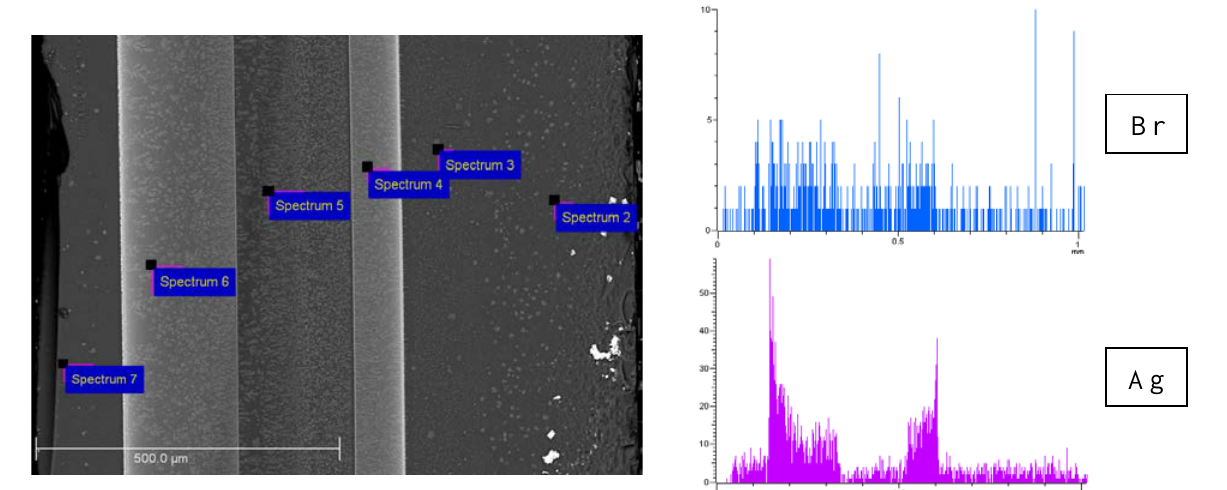
Figure 5. SEM image of the cross-section of the Ag/AgBr/MAP membrane and element distribution over 1 mm thickness (Br—blue, Ag—purple). Table 1. EDX cross-section element (except for Si, O) atomic concentration (at %) of the Ag/AgBr/MAP membrane.